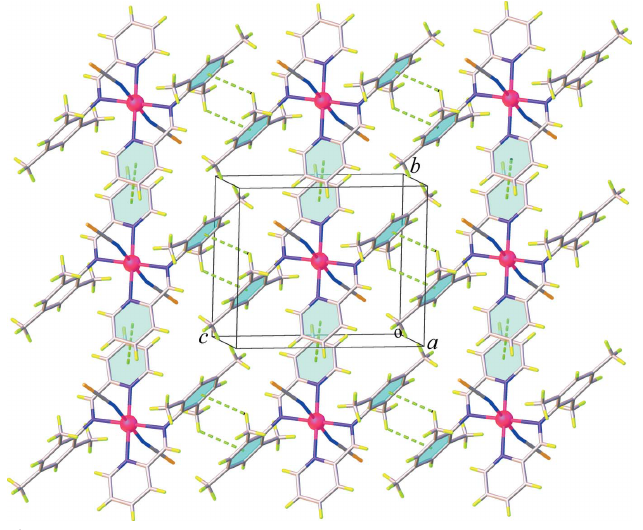
Figure 7 Crystal packing of ( II ) viewed along the c axis with aromatic (cid:2) – (cid:2) stacking interactions bonds shown as dashed